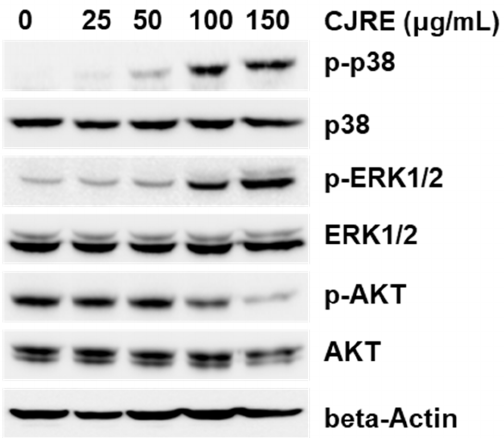
Figure 5. CJRE induced phosphorylation of p38 and ERK1/2 in HeLa cells. HeLa cells were treated with different doses of CJRE for 24 h, and whole cell lysates were subjected to Western blotting with indicated antibodies.